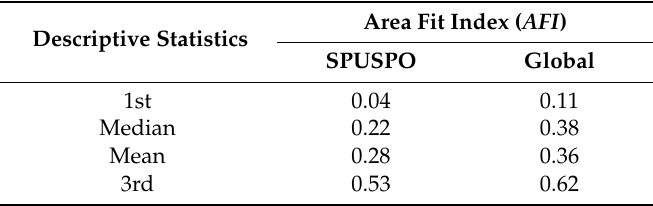
Table 3. Area Fit Index for building objects in Ouagadougou. Values closer to 0 suggest a better segmentation, values > 0 imply over segmentation while values < 0 under